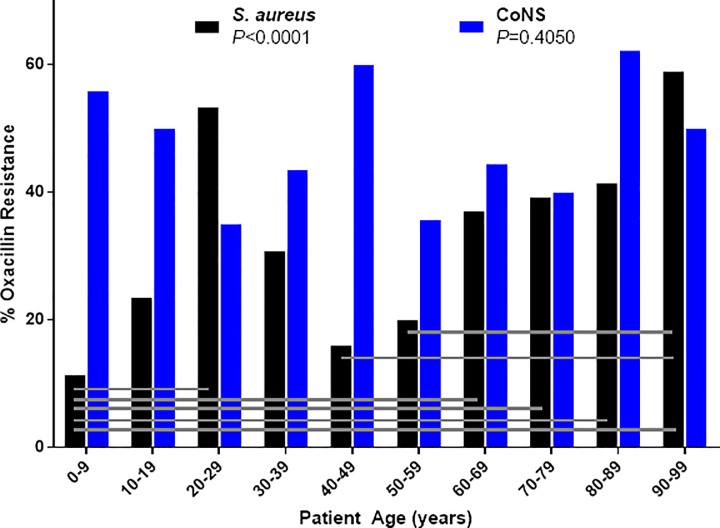
Oxacillin resistance among conjunctival isolates of staphylococci by patient age.Data are expressed by decade of life for percentage of oxacillin resistance among S. aureus and CoNS; P-values are from Chi-Square test. Horizontal lines represent significant pairwise differences (P<0.05). Abbreviations: CoNS, coagulase-negative staphylococci.